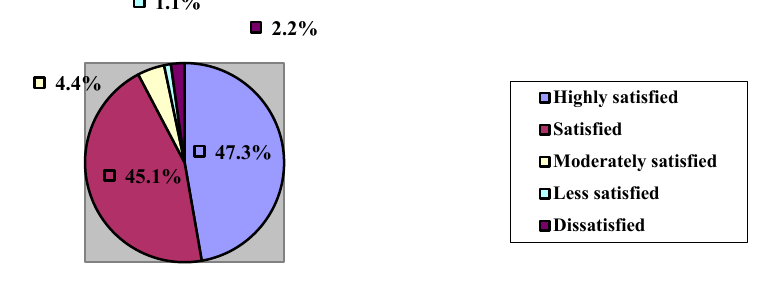
Figure 7. The level of satisfaction of visits to the wineries.